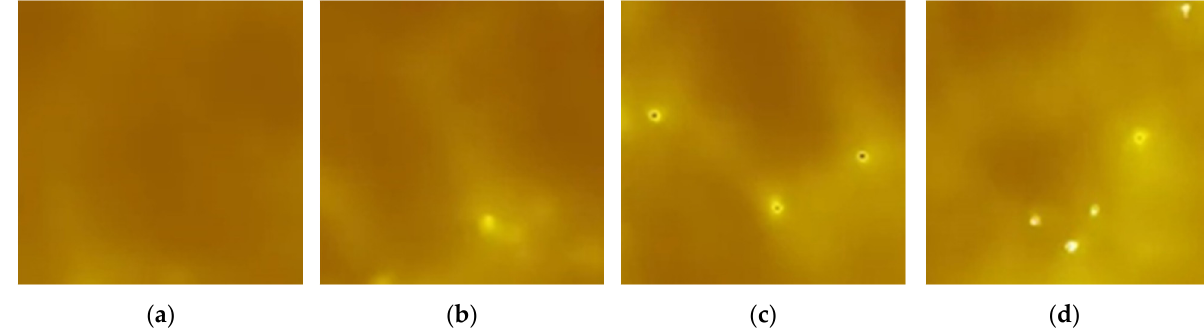
Figure 15. Example of image analysis, evolution of the universe (zoomed view): Images of millions of years after the Big Bang ( a ) 1000; ( b ) 2000; ( c ) 3000; ( d ) 6000. Source: [39].